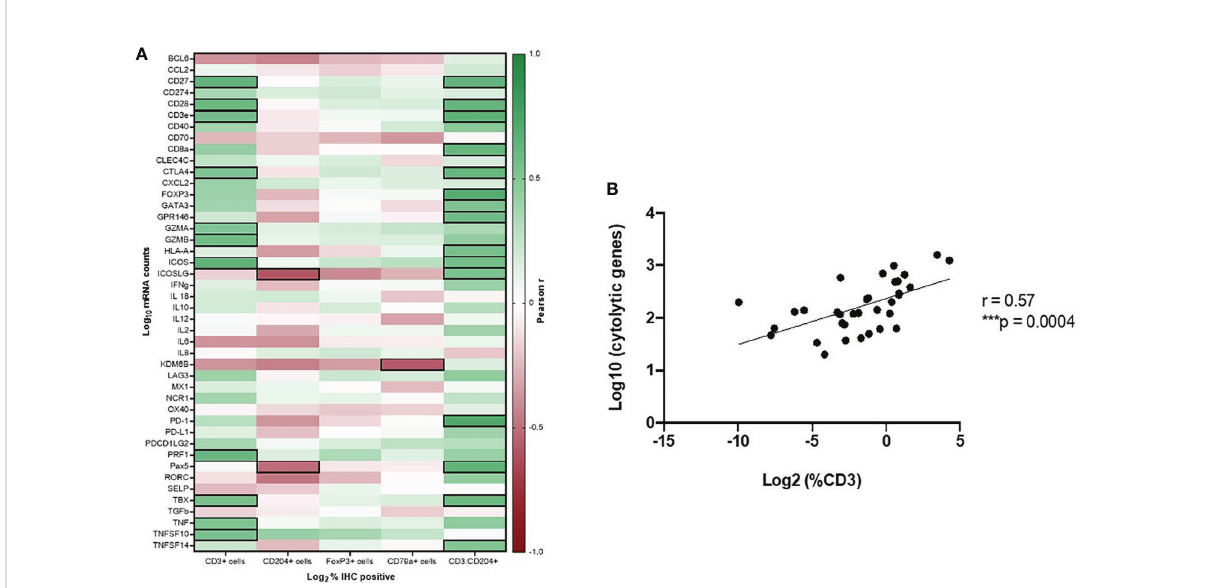
FIGURE 5 Gene expression pro fi ling to determine immune function of tumor-in fi ltrating leukocyte subsets in canine OSCC. (A) Pearson correlation matrix of immune cell densities of all analyzed cell types, as determined by IHC, with Nanostring gene expression data. Black boxes denote statistically signi fi cant (p < 0.05) correlations with r values > 0.5 or < -0.5. (B) Spearman correlation plot of CD3-IHC+ cell density with cytolytic activity score (mean perforin and granzyme expression